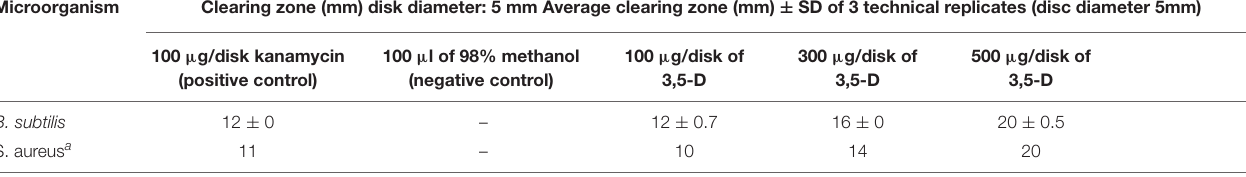
TABLE 1 | Antimicrobial activity of 3,5-dichloro-4-methoxybenzoic acid (3,5-D) tested against Bacillus subtilis and Staphylococcus aureus.